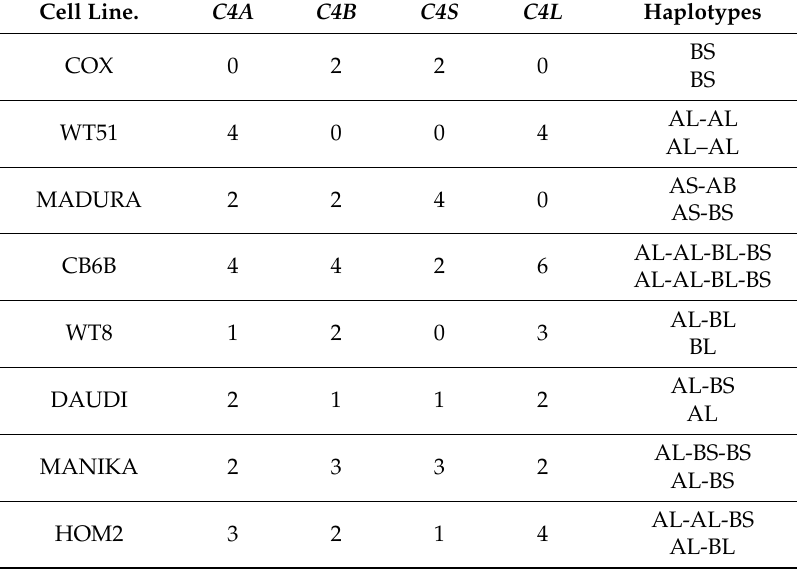
Table 1. Selection of human cell lines with known C4 CNV genotype [6,15]. Cell Line.